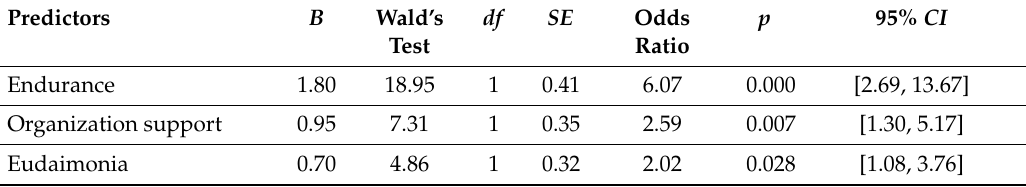
Table 4. Results of the binary logistic regression to predict post-traumatic growth.